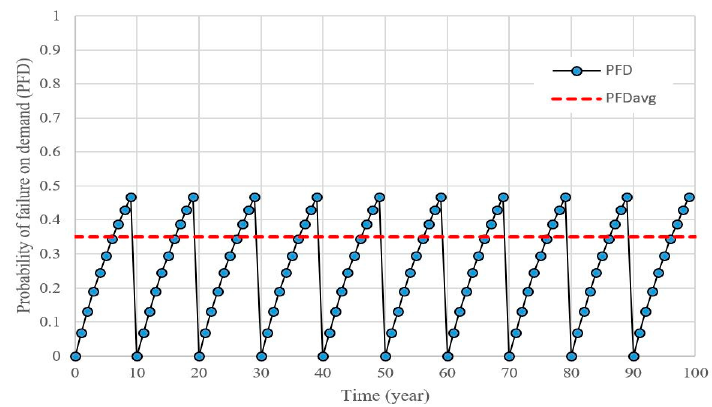
Figure 3. Changes in probability of failure on demand (PFD) across a year, and the average probability of failure on demand (PFDavg) (adapted from [43]).